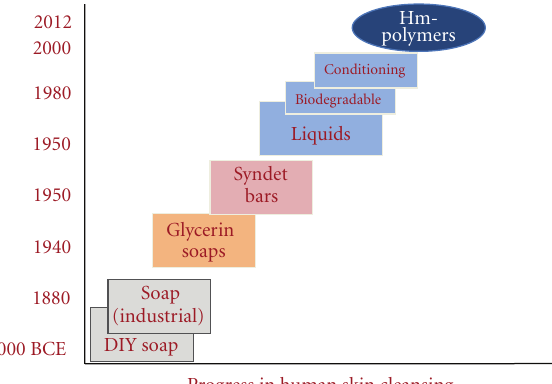
Figure 2: Progress of technology and skin compatibility of human skin cleansing over time. Adapted from Walters